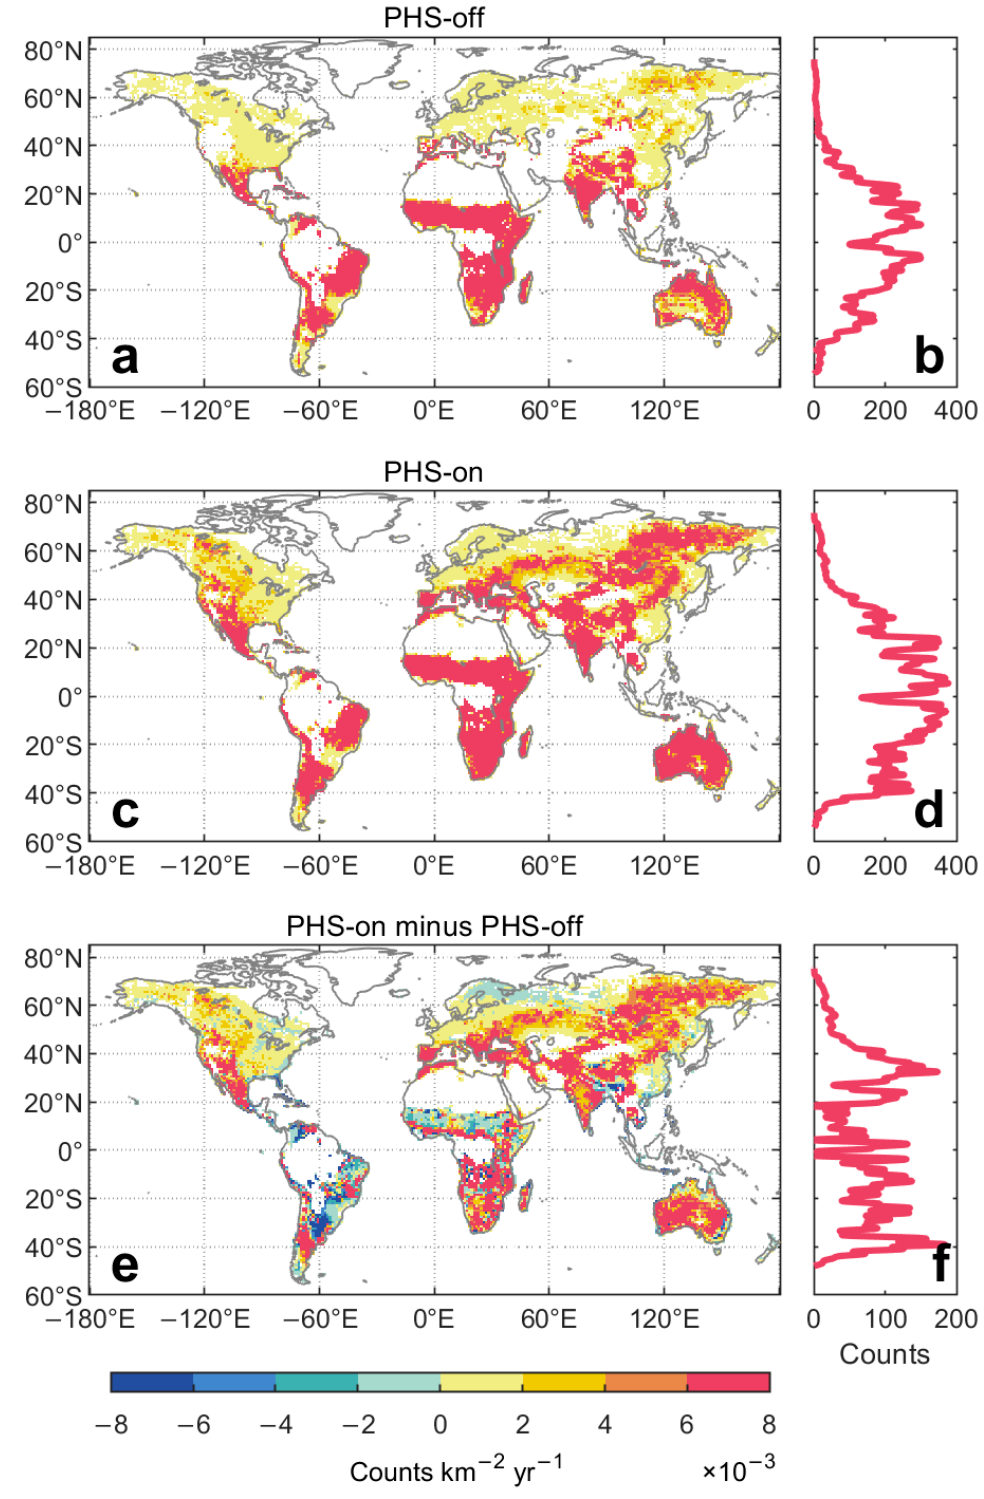
Figure 4. Spatial distributions of the temporally averaged (1850–2010) fire count from CLM5 simu- lations without (PHS-off, ( a , b )) and with PHS (PHS-on, ( c , d )) configurations and their differences (PHS-on minus PHS-off, ( e , f )). The pixels in the left panels represent fire count per unit area (Counts km − 2 yr − 1 ) and the vertical thick lines in ( b , d , f ) represent the latitudinal amount with area multiplied in corresponding left panels.